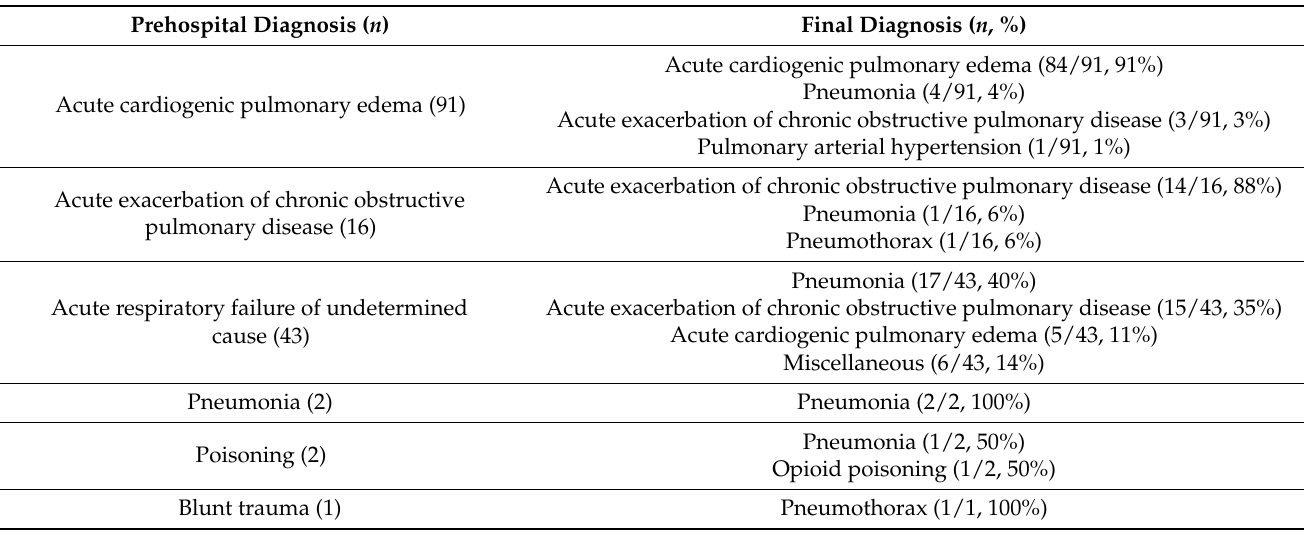
Table 3. Comparison of the prehospital and final diagnoses of the 155 patients with prehospital noninvasive ventilation and the available hospital data.